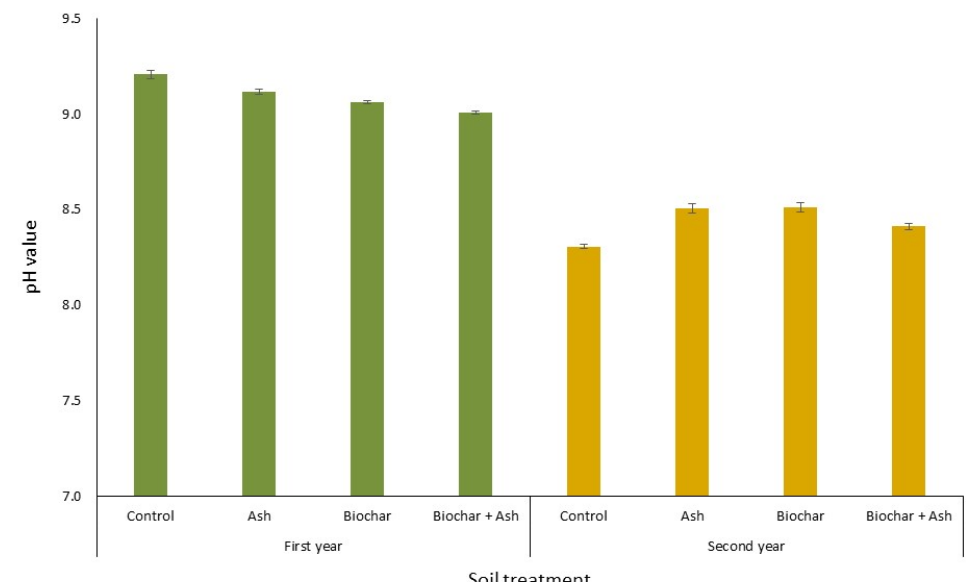
Figure 1. Pyrolysates’ pH, produced from basket willow biomass collected from the control, ash, biochar, and biochar + ash soil treatment plots, one and two years after planting ( n = 12). In accordance with the result of the Bonferroni test, the pH values were not significantly ( α ≤ 0.05) different among treatments (separate comparison for each year).